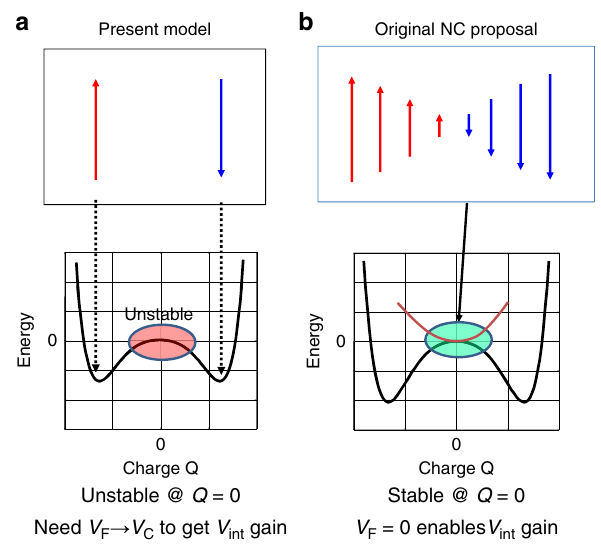
Fig. 5 Comparison of present view with initial NC proposal. a In present view, V int gain is associated with polarization fl ip, and the intermediate state between two polarization states is unstable. Thus, V F > V C is required to get V int gain. b In the original NC proposal, the intermediate state can be stabilized by changing the polarization value. Then even V F = 0 enables a V int gain